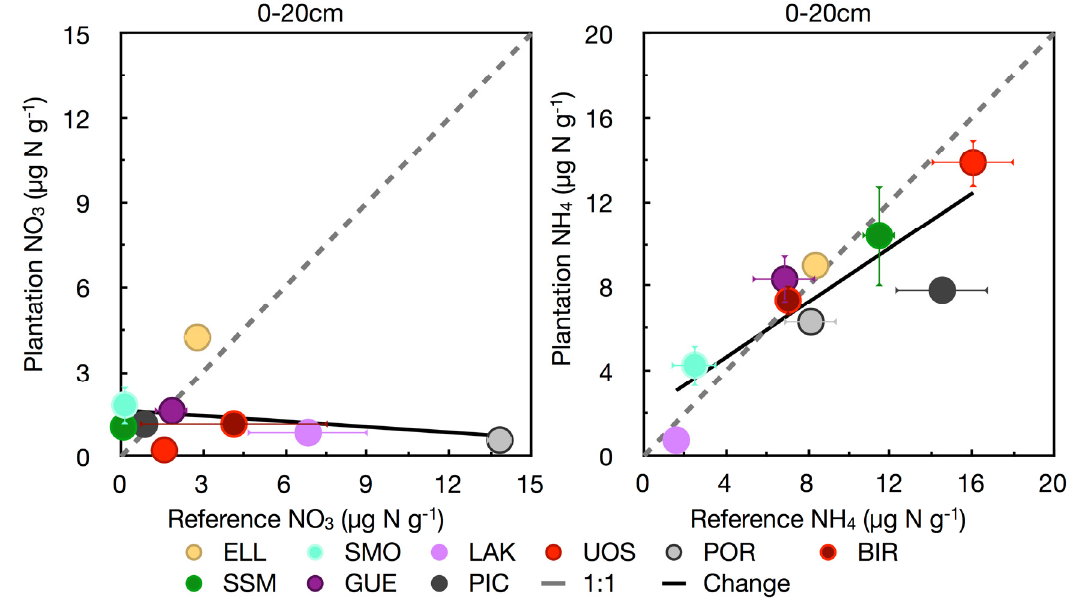
and NH as estimated from reference sites, versus Figure 2. Initial concentration of NO 3 4 NO and NH in plantations after the first rotation of nine S. purpurea “Hotel” plantations 3 4 (ELL, SMO, LAK, UOS, POR, BIR, SSM, GUE, and PIC). Error bars represent standard error when greater than symbol